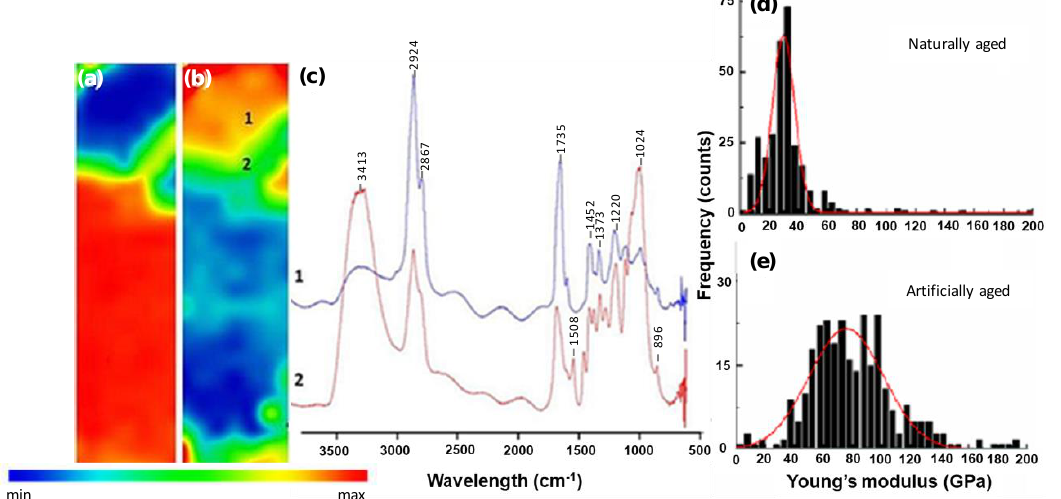
Figure 3. ( a – d ) shows SR-micro-FTIR mapping for the naturally aged oil-based varnish (Figure 2 sample 1): chemical image mapping of the absorbance at ( a ) 1000 cm −1 and ( b ) 1735 cm −1 , respectively, and ( c ) photomicrograph of the microtomed cross-section of width 10 µ m. (the squared area outlined in black has a depth of 250 μ m and indicates depth of penetration of the oil into the wood); and ( d ) FTIR spectra of layers (1, 2, 3) as shown in ( b ) and corresponding to varnish, penetration areas of oil in wood, and oil, indicating high penetration into the wood porous structure (around 200 µm). ( e – f ) shows mechanical data and distribution of Young’s modulus in the unaged which, at time of analysis, had undergone four years of natural ageing in the dark ( e ) and the artificially accelerated aged sample ( f ) where median values of Young’s modulus are (7.04 +/ − 1.75) GPa and (57.2 +/ − 5.1) GPa, respectively.